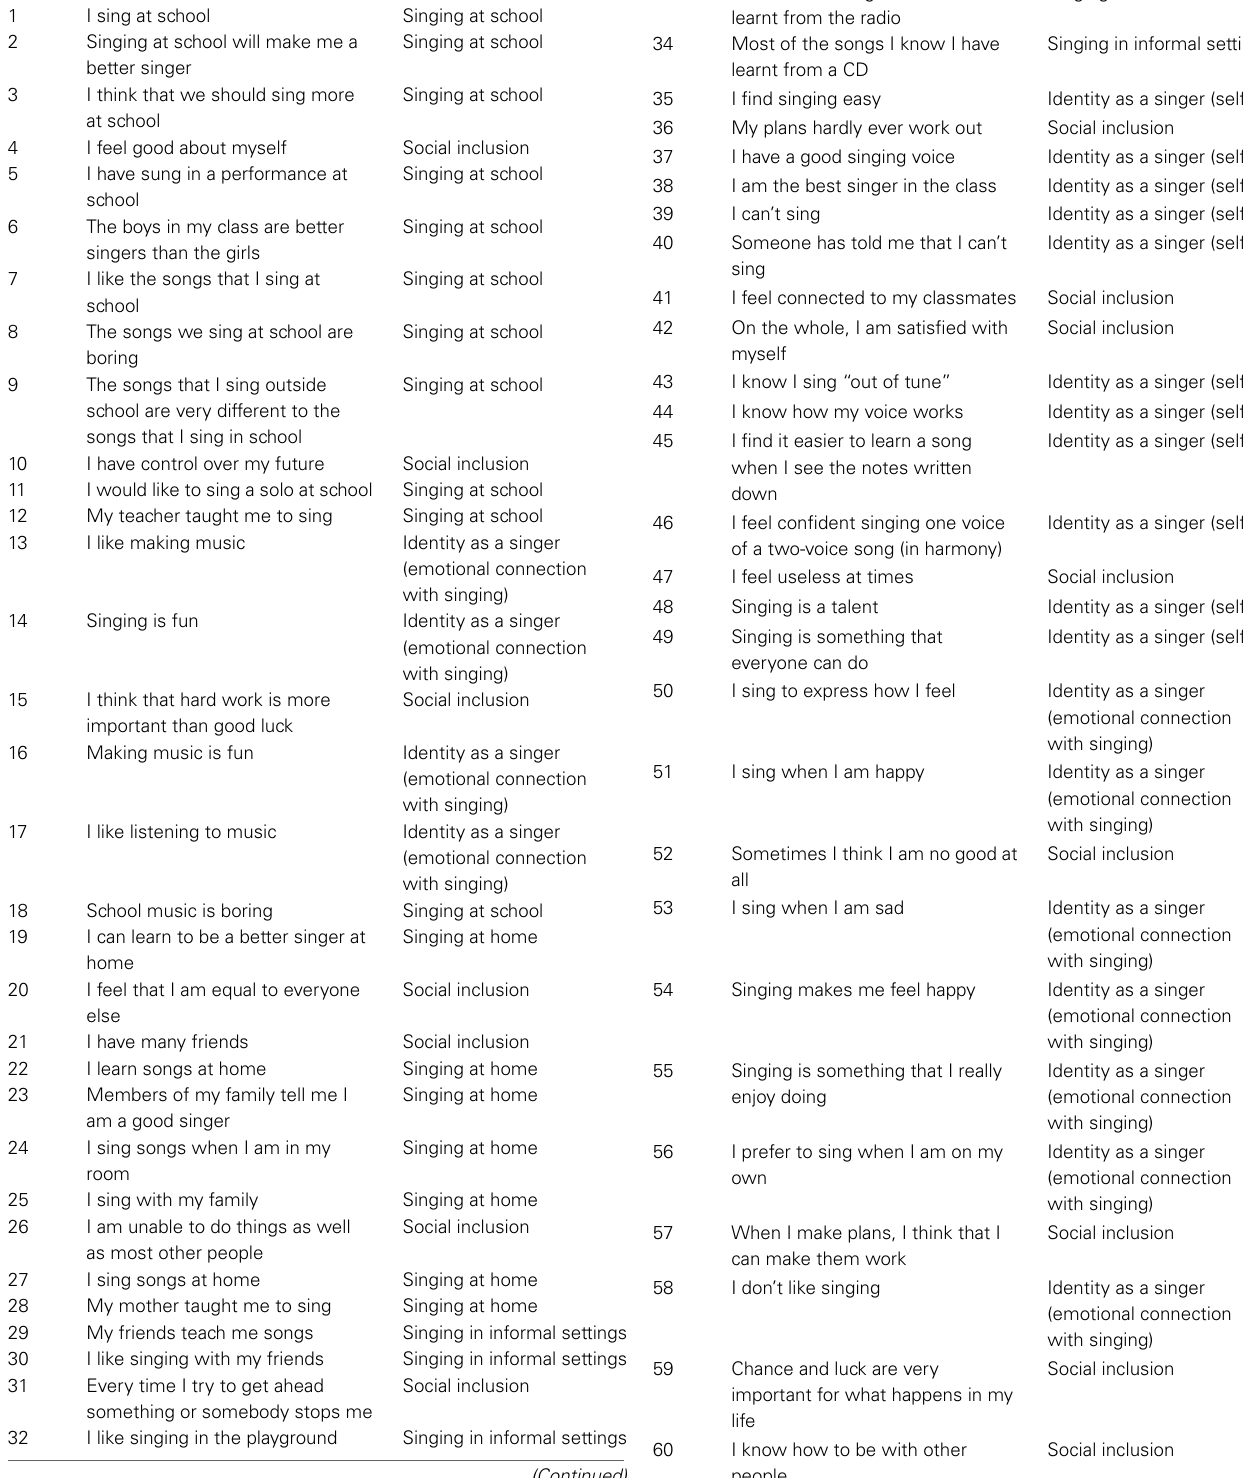
Table 1 | National Singing Programme Sing Up Questionnaire with themes, 60